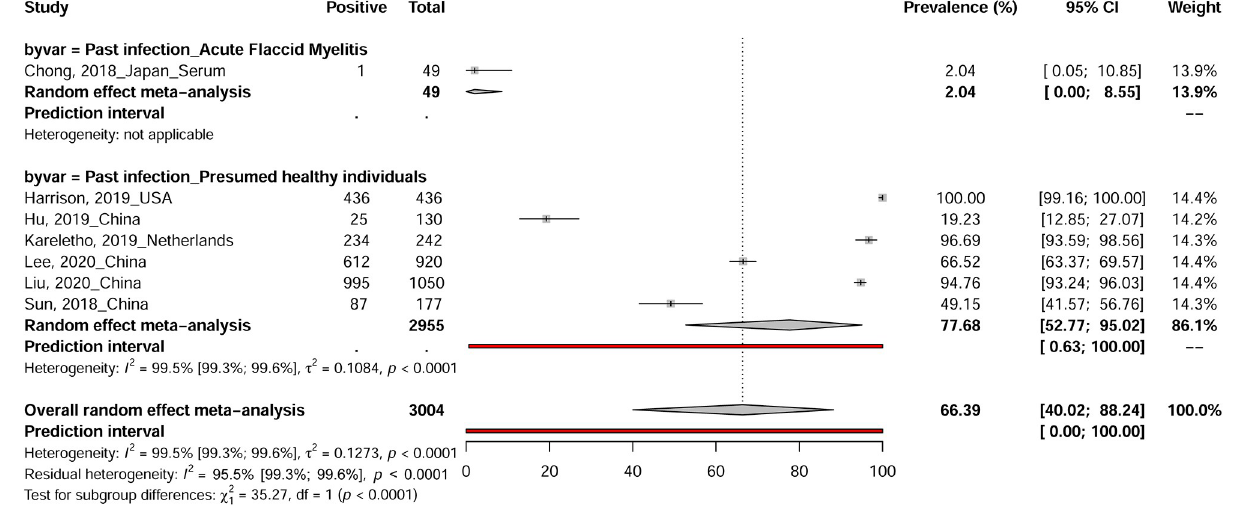
Fig 5. The pooled global prevalence of Enterovirus D68 past